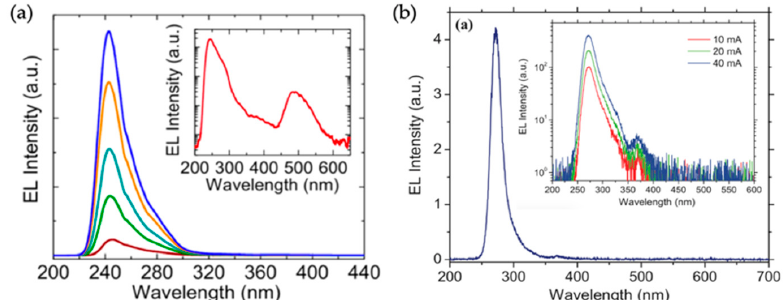
Figure 3. ( a ) EL spectra of AlGaN nanowire tunnel junction deep UV LEDs emitting at 242 nm under injection currents varying from 2 to 60 mA. Device size: 0.5 mm × 0.5 mm. Inset: the EL spectrum